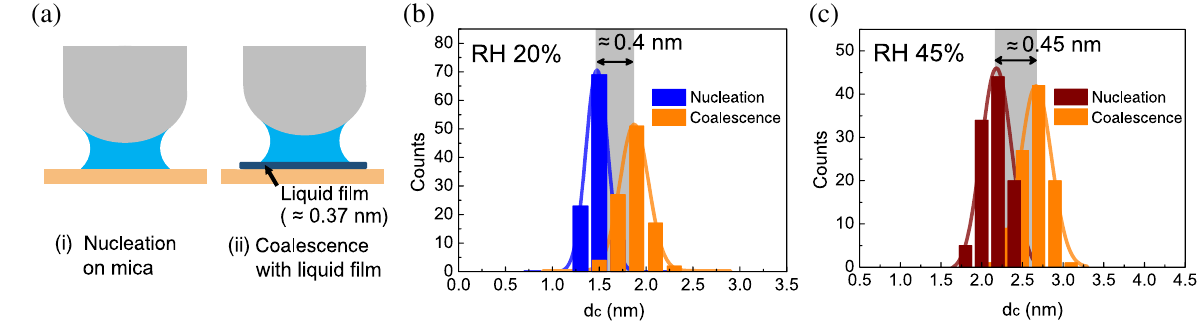
FIG. 4. (a) Liquid film is adsorbed on the mica with about 0.37 nm thickness (monolayer of water) and 100 nm width at RH below 50% [29,30]. We performed numerous approach-retraction processes at various RH and found there are two distinct values of d , separated by c the liquid-film thickness when RH ≥ 20% . (b) At 20% RH, d is either 1 . 5 (cid:2) 0 . 1 nm or 1 . 9 (cid:2) 0 . 16 nm depending on the local presence of c liquid film. (c) At 45% RH, two differing d values are 2 . 18 (cid:2) 0 . 15 nm and 2 . 63 (cid:2) 0 . 2 nm. We performed 100 approaches in each case for c statistical analysis. The contribution of coalescence due to the liquid film systematically increases the measured critical distance by the thickness of the water monolayer. Our data analysis considers only those results corresponding to pure nucleation.